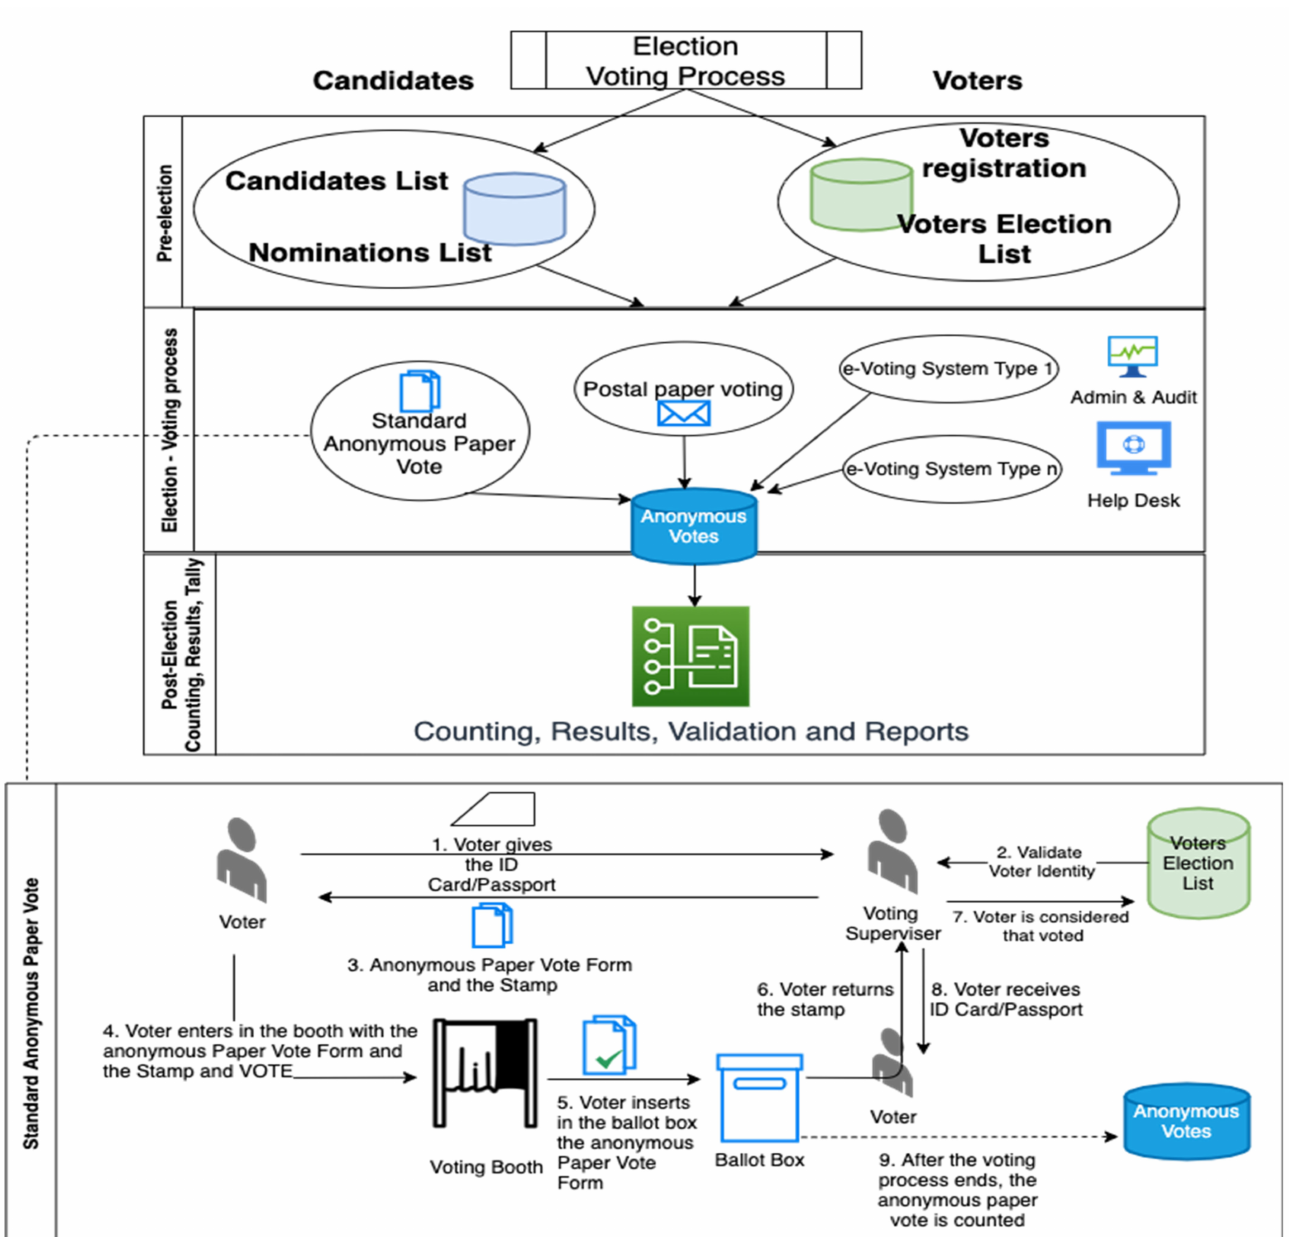
Figure 1. Simplified overview of the voting